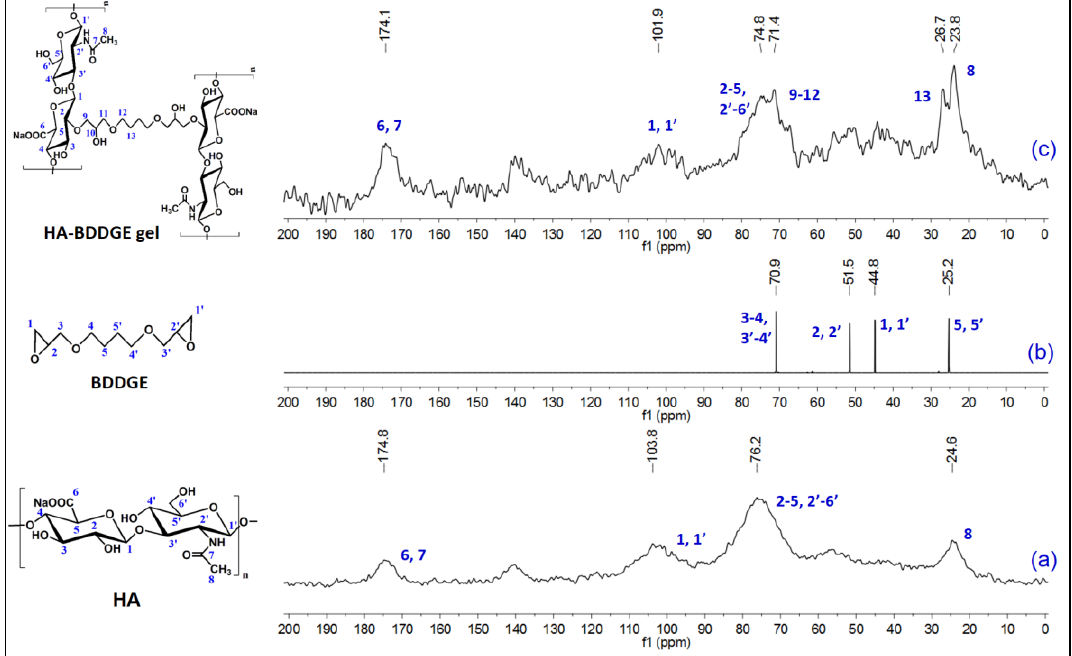
Figure 2. 13 C NMR spectra of ( a ) HA (solid state), ( b ) BDDGE (liquid state), and ( c ) dried HA-BDDGE gel (solid state).